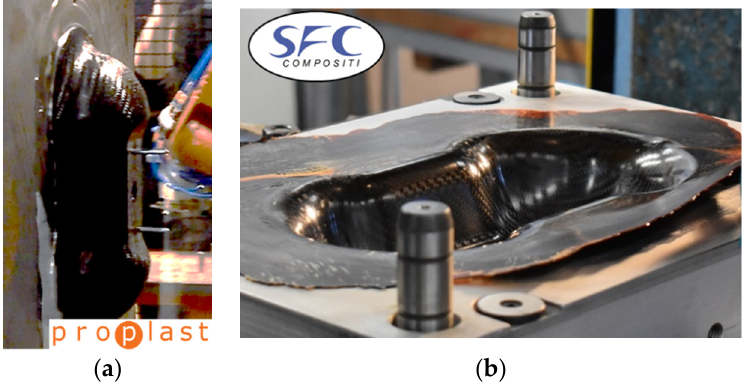
Figure 27. GF/PP and CF/PA66 Double Dome obtained by Horizontal Press ( a ), CF/EP-Angeloni and CF/EP-Solvay Double Dome obtained by Vertical Press ( b ).